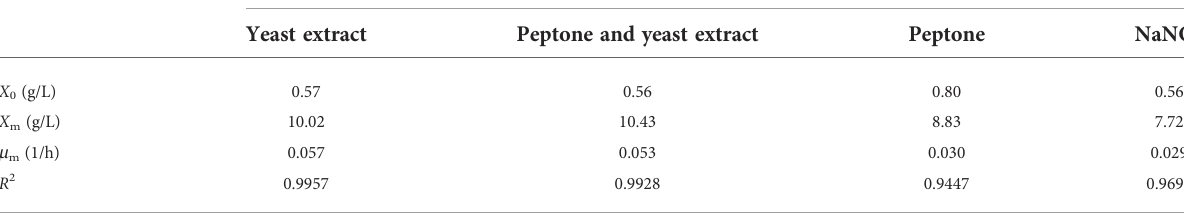
TABLE 2 Kinetic parameters for growth of A. limacinum SR21 in half-strength ASW-based media containing 30 g/L glucose and four different nitrogen sources.